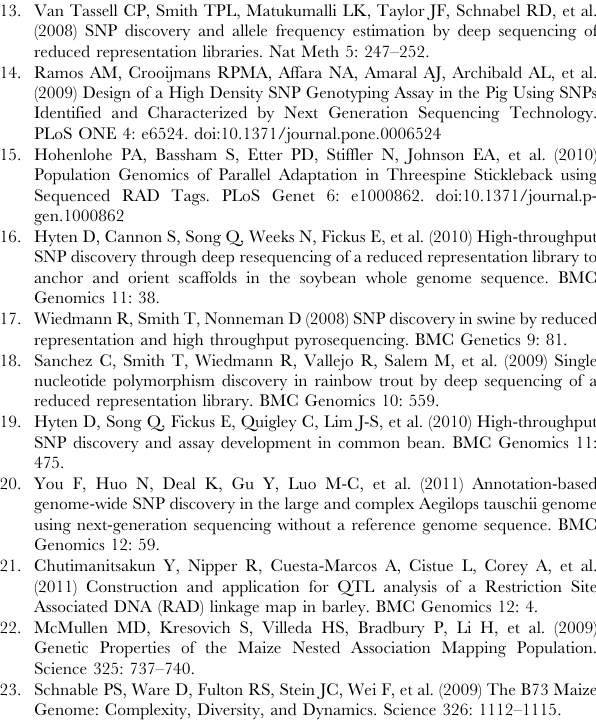
Figure S8 Maternal linkage groups in a biparental switchgrass family and their alignment to foxtail millet genomes. (A) 3,000 markers were clustered into 19 groups. (B) The 19 groups were aligned to the foxtail millet genome. The majority of the SNPs on each linkage group aligned to the same chromosome of the foxtail millet genome (red dots); there were some exceptions, however (blue dots). In most cases, each foxtail millet chromosome matches two linkage groups of switchgrass. The sole exception, chromo- some 1, has three matching linkage groups (1, 3 and 10). Based on later analyses, we merged linkage groups 1 and 3. Figure S9 Pairwise Spearman’s rank correlation coefficient (r) of ordered markers on paternal linkage group 12. A total of 228 markers were ordered based on their alignment to the foxtail millet genome. Pairwise r was calculated for these markers. The high r values were distributed along the diagonal. Figure S10 Neighbor-Joining tree of 540 individuals from 66 diverse populations of switchgrass. In the tree on the left, the red branches indicate the upland ecotype of switchgrass. The blue branches are the lowland ecotype. Details of a portion of the tree are shown on the right. Individuals within a box are from the same population. Figure S11 Switchgrass ecotypes with different ploidy levels resolve into distinct phylogenetic clades. Figure S12 Switchgrass Neighbor-Joining phylogeny construct- ed with 3,144 markers. Foxtail millet was used as an outgroup.